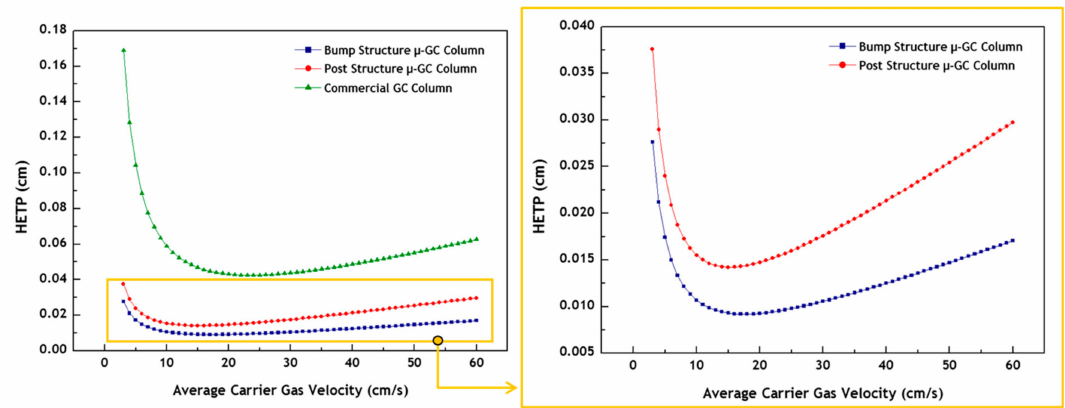
Figure 5. Height-equivalent-to-a-theoretical-plate (HETP) versus average carrier gas velocity for the commercial GC column and the µ -GC columns of bump and post